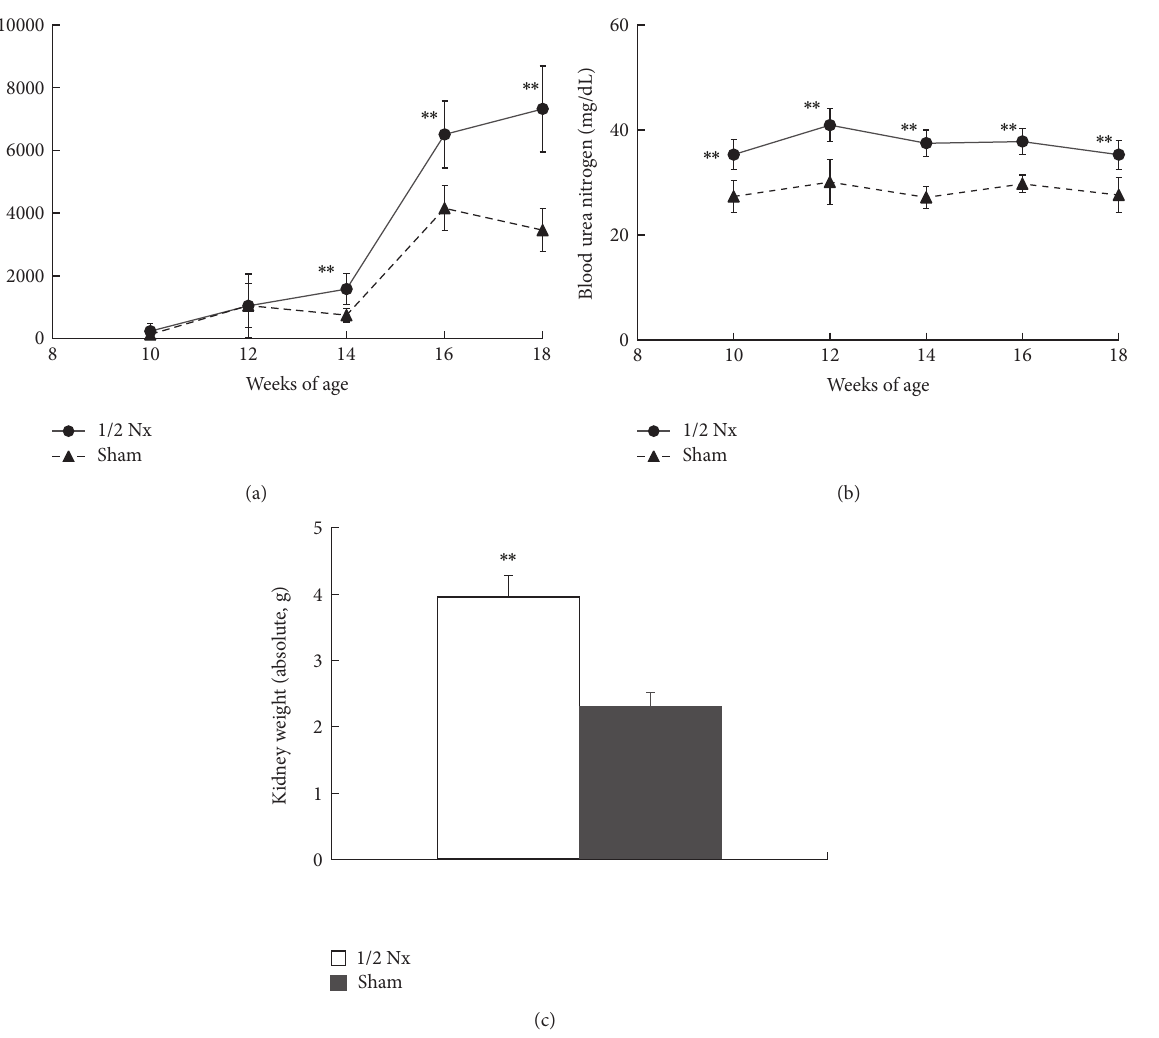
Figure 1: Changes in renal parameters ((a) urinary albumin, (b) blood urea nitrogen, and (c) kidney weight) in the 1/2 Nx group and sham group. Data shown as means ± SD ((a) and (b) 𝑛 = 8 –10 and (c) 𝑛 = 8 -9). ∗∗ 𝑃 < 0.01 ; significantly different from the sham